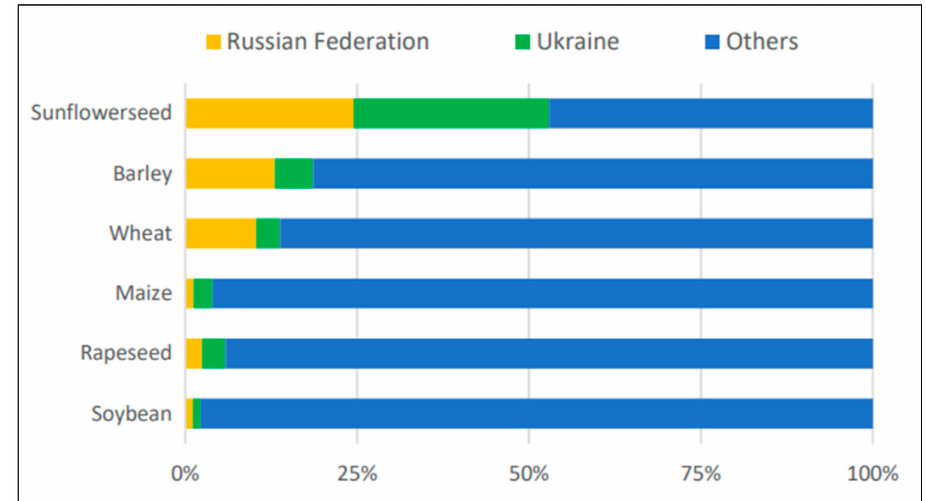
Figure 3. Share of Russia and Ukraine in global exports of selected crops. Source: FAO